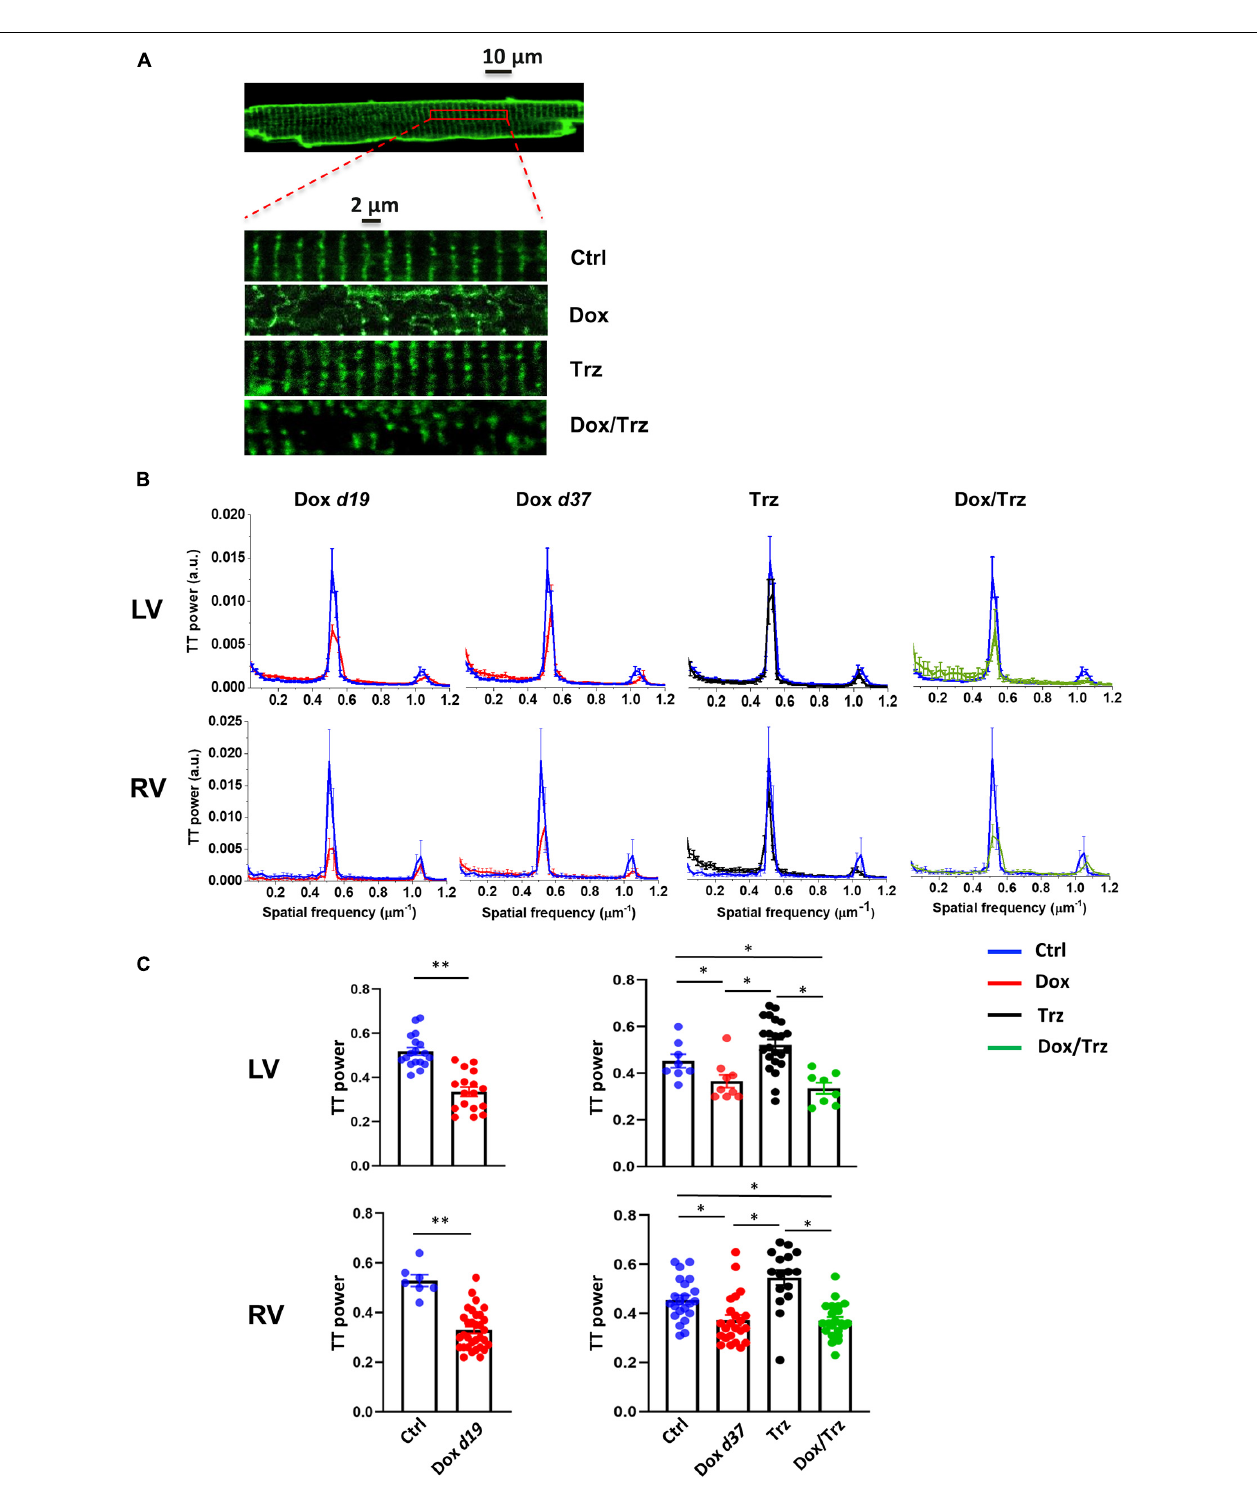
FIGURE 2 | Effects of Dox and Trz on TT organization. (A) Confocal regions of interest (ROI) of a 3-di-ANEPPDHQ–treated LV CM from a Ctrl rat, and representative higher-magnification LV CM confocal ROI in all groups. Disruption of TT organization in the Dox and Dox/Trz groups, but not in the Trz group, is apparent. (B) Mean TT power spectra in LV and RV CMs in Dox (red), Trz (black) and Dox/Trz groups (green) at the indicated time points, superimposed to those in the Ctrl group (blue). (C) Quantitative analysis of the TT periodic component in LV and RV CMs. Data on the Dox group is shown at d19 and at d37. Unpaired Student’s t -test and one-way ANOVA were used to test for significant differences at d19 and d37, respectively. Bars are mean ± SEM ( n = ≥ 15 cells from ≥ 3 rats/group; * p < 0.05; ** p < 0.01).